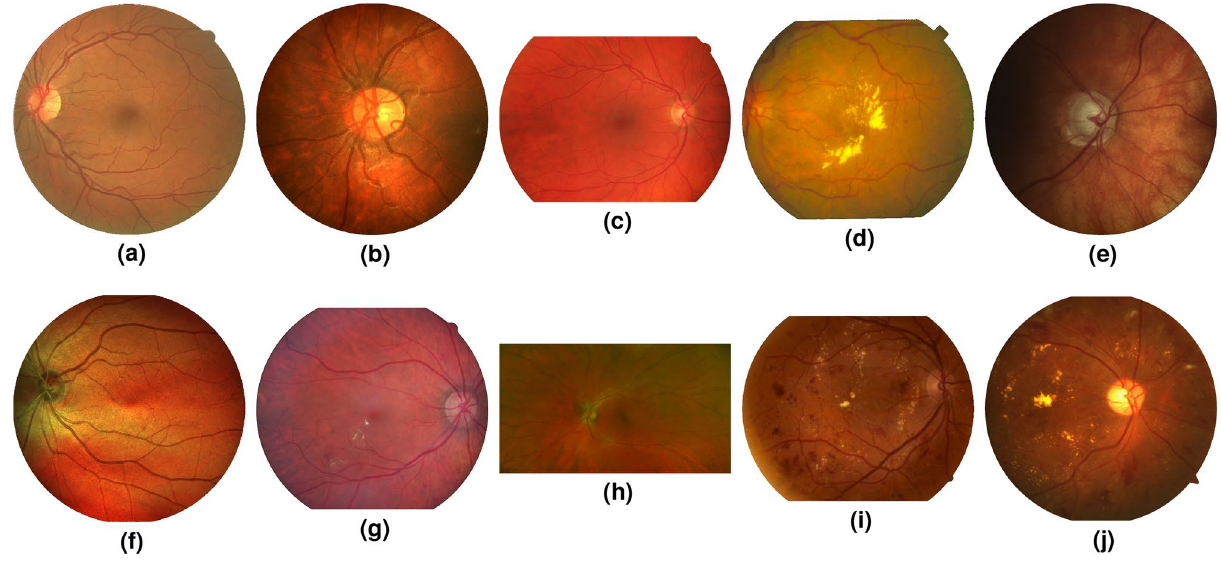
CHASE-DB 1 2 , ( c ) HRF 3 , ( d ) STARE 4 , ( e ) LES-AV 5 , ( f ) IOSTAR 6 , ( g ) DR HAGIS 7 , ( h ) AV-WIDE 8 , ( i ) DRIDB 9 ,